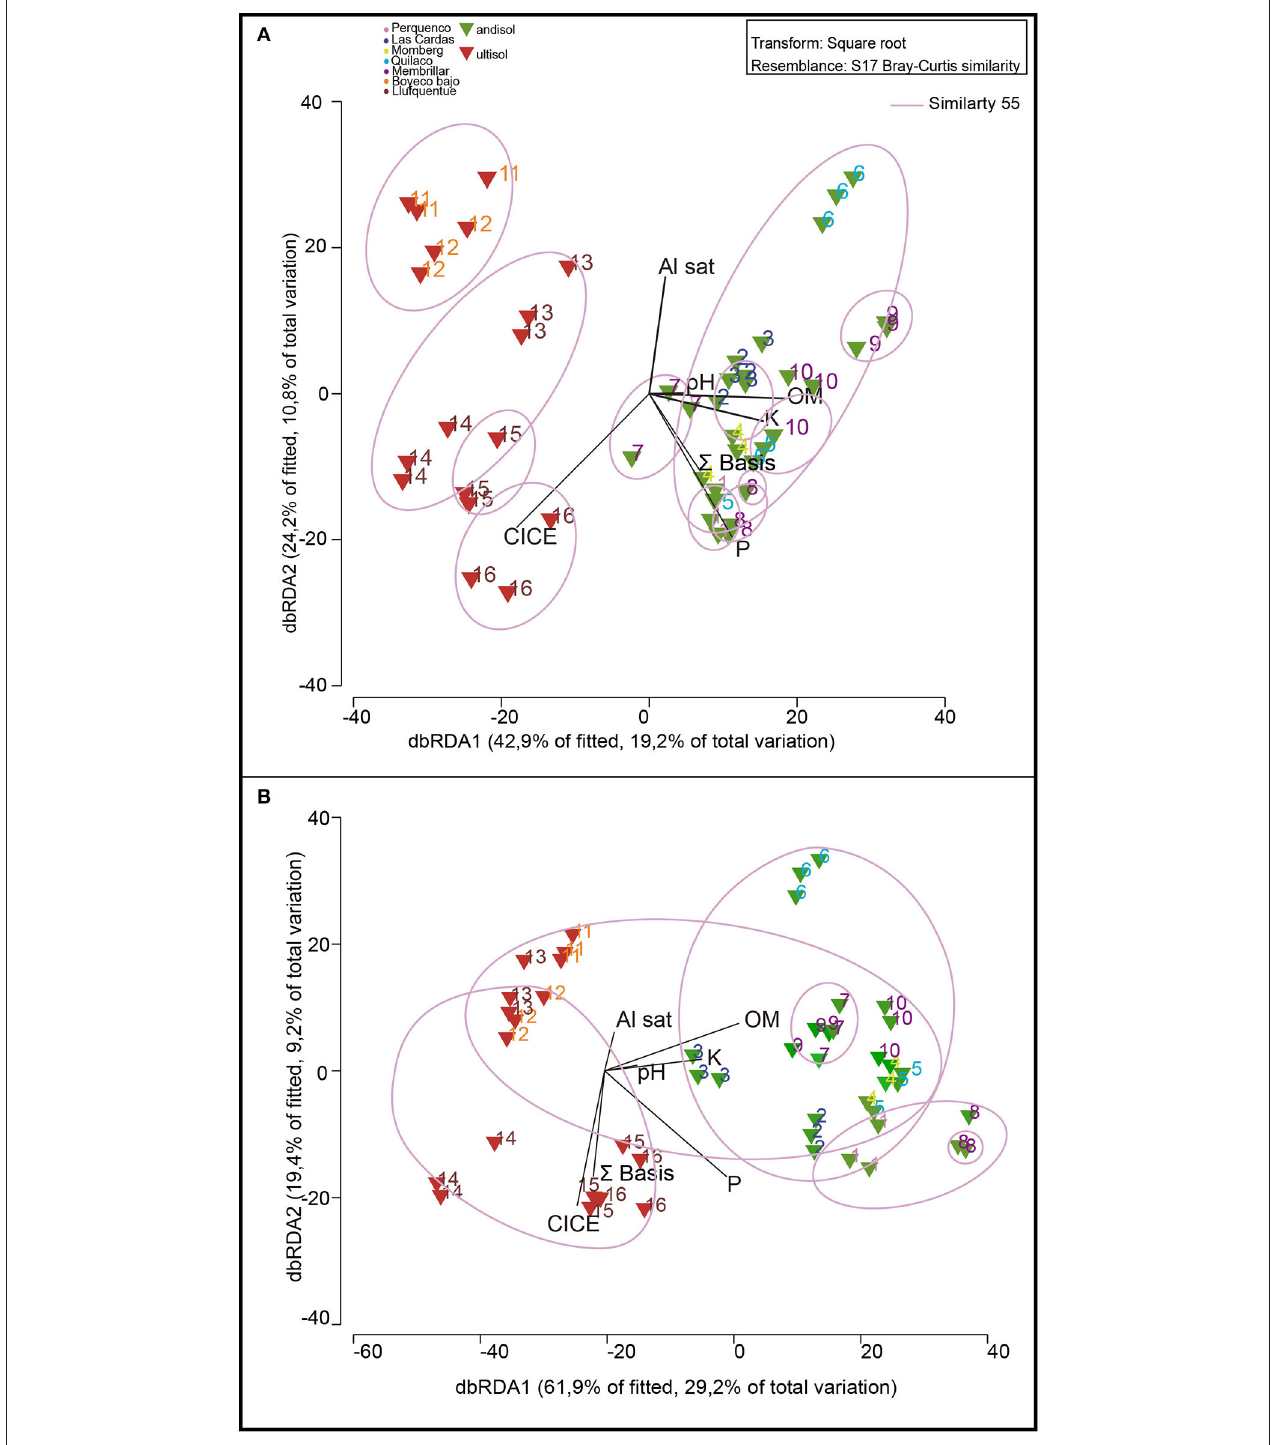
FIGURE 2 | Non-metric Multidimensional Scaling (NMDS) analysis of the 16 soils used in this study based in DGGE profiles of bacterial communities in relation with soil parameters (P, K, OM, Al sat, CICE, and 6 basis). Color of numbers represent sector of sampling and triangle colors indicate type of soil: andisol (green) and ultisol (red). The length and position of the black lines (soil parameters) indicate correlation strength and direction of significant variables ( P < 0.05) with the microbial community of rhizosphere (A) and bulk soil (B) .